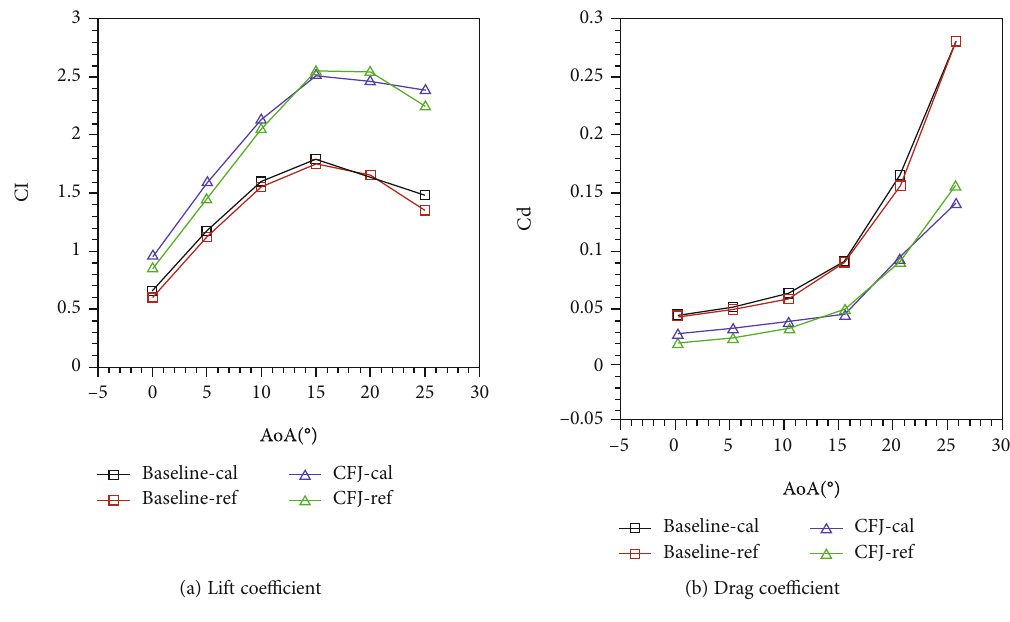
Figure 4: Variation of the lift and drag coe ffi cients of the NACA6415 baseline and CFJ airfoils.